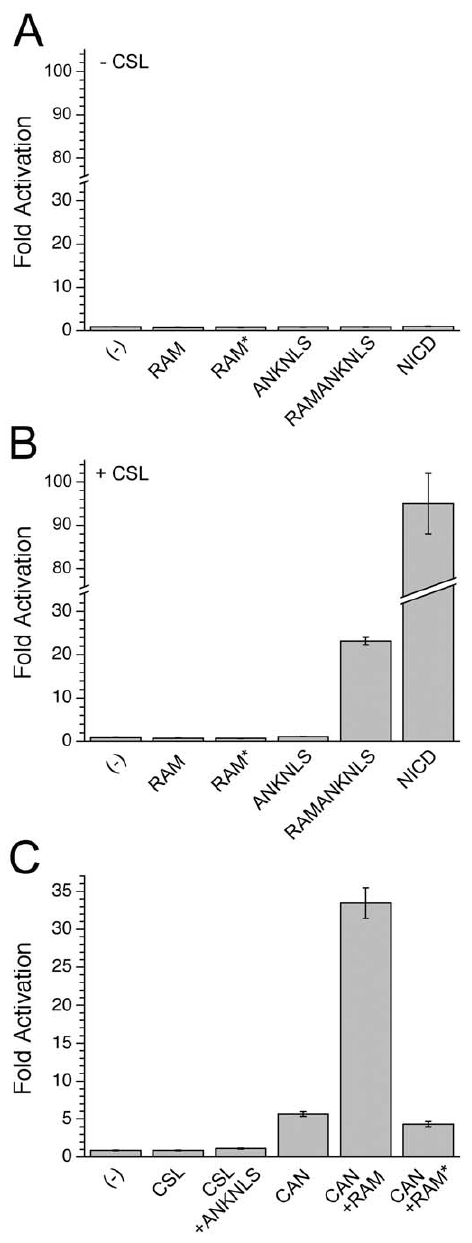
Figure 3. CSL-dependent transcription assays in OT11 allow determination of minimal requirements for ternary complex formation. A). In the absence of CSL, neither full-length NICD nor fragments of NICD can activate transcription. B). In the presence of CSL, only RAMANKNLS and NICD result in transcriptional activation. C). Fusion of CSL-ANKNLS (CAN) activates transcription 6-fold over empty vector alone (and relative to CSL and ANKNLS), consistent with an increased effective concentration of ANK at the CTD of CSL. Co- transfection of RAM with CAN further increases transcriptional activation, implicating an additional role of RAM in forming the active ternary complex.